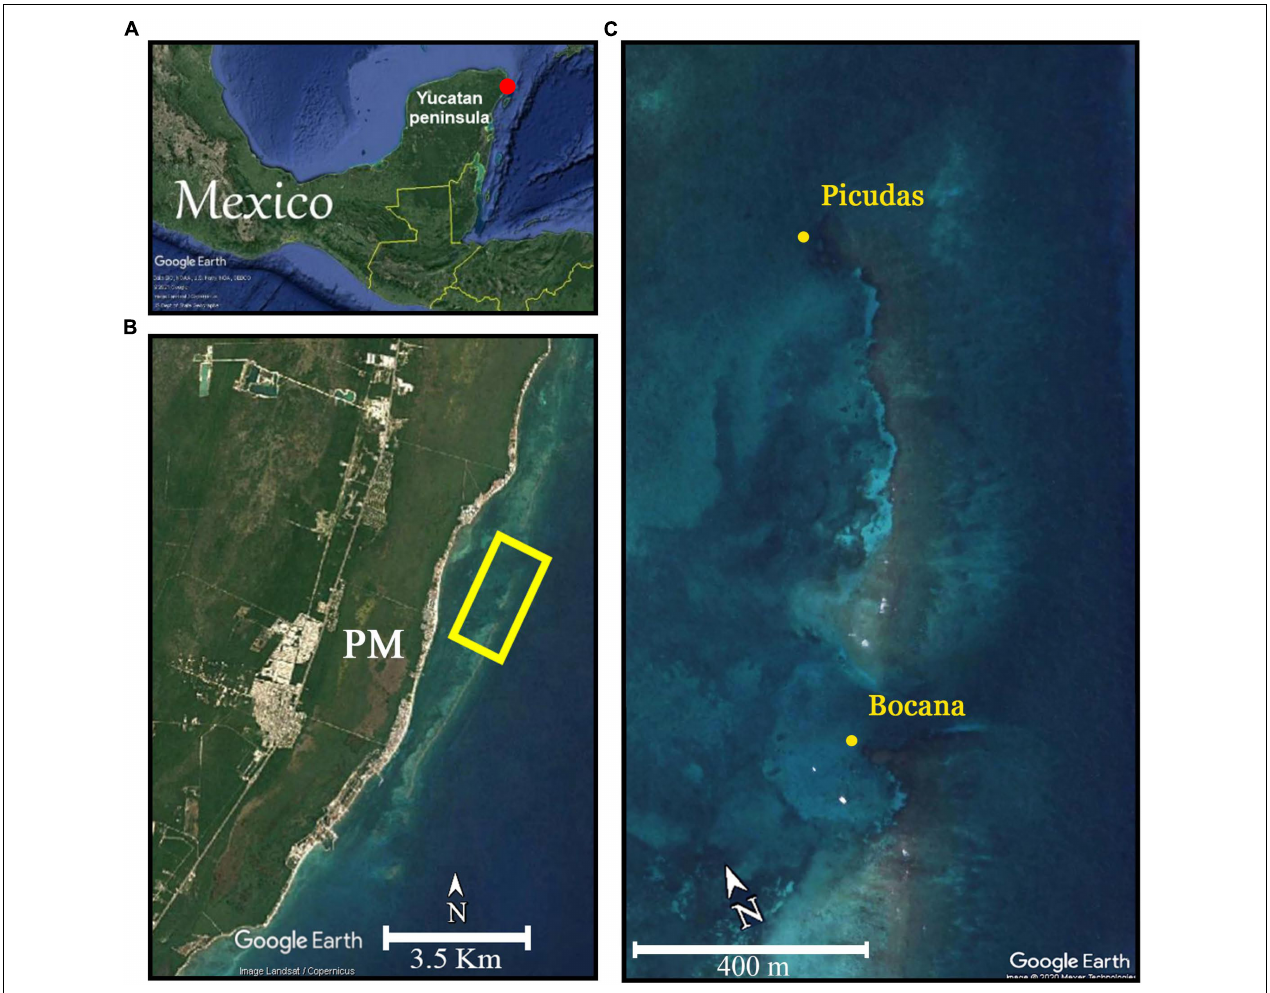
FIGURE 1 | (A) The red point shows the location of the area zone in the Mexican Caribbean. (B) Puerto Morelos reef off the coast of the Puerto Morelos town (PM) and reef area of study sites deployment (yellow square). (C) Location of Bocana and Picudas study